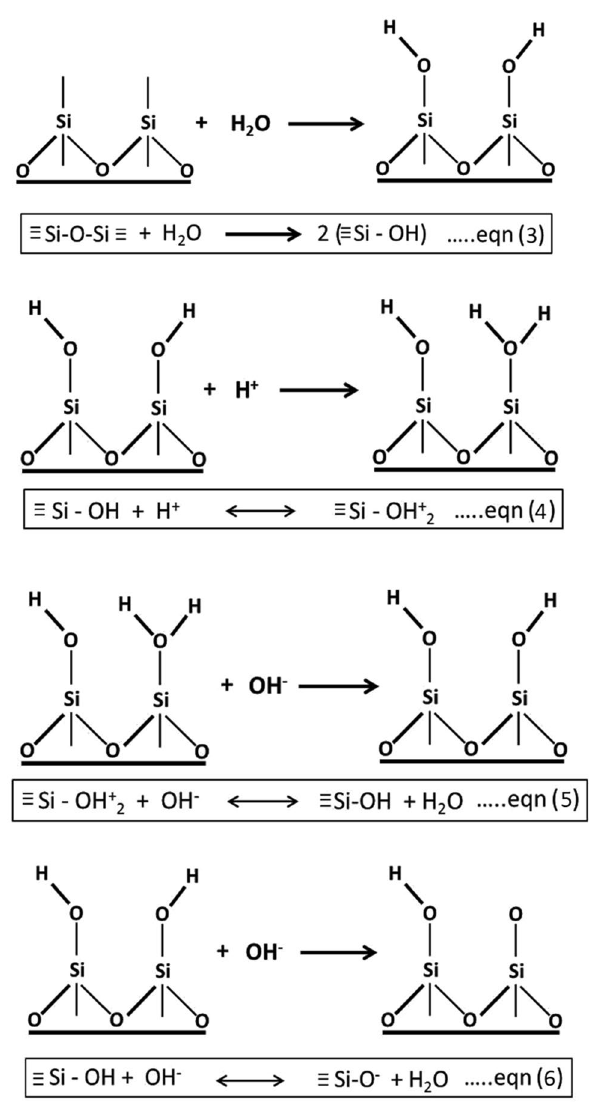
Fig. 16 Proposed hydrolysis steps of quartz